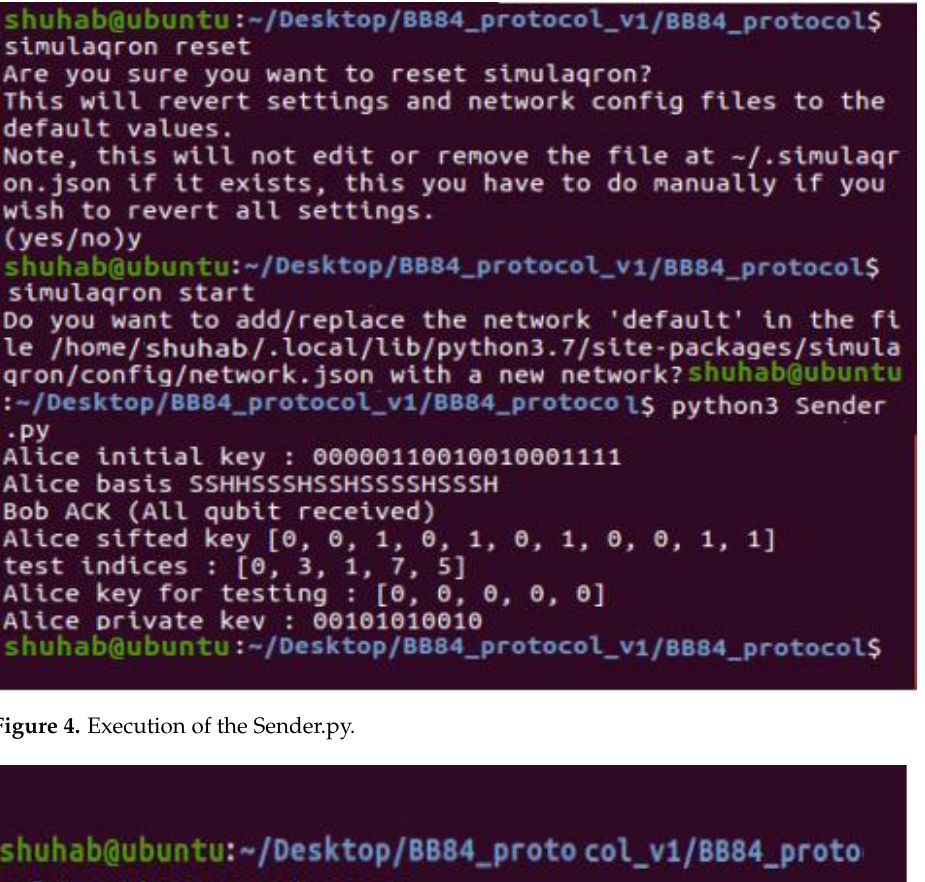
Figure 3. Execution of the proposed protocol.